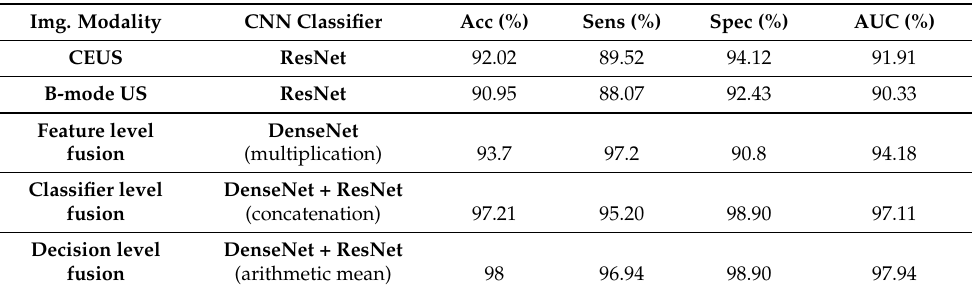
Table 9. The values of the performance parameters obtained on the validation set for the best performing multimodal